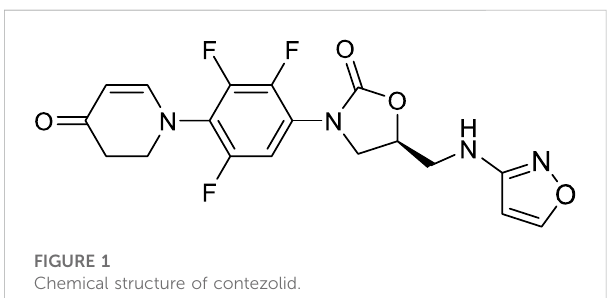
FIGURE 1 Chemical structure of